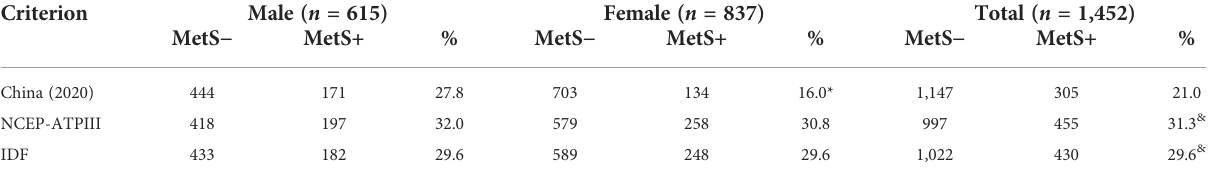
TABLE 3 Prevalence of MetS by different criteria.